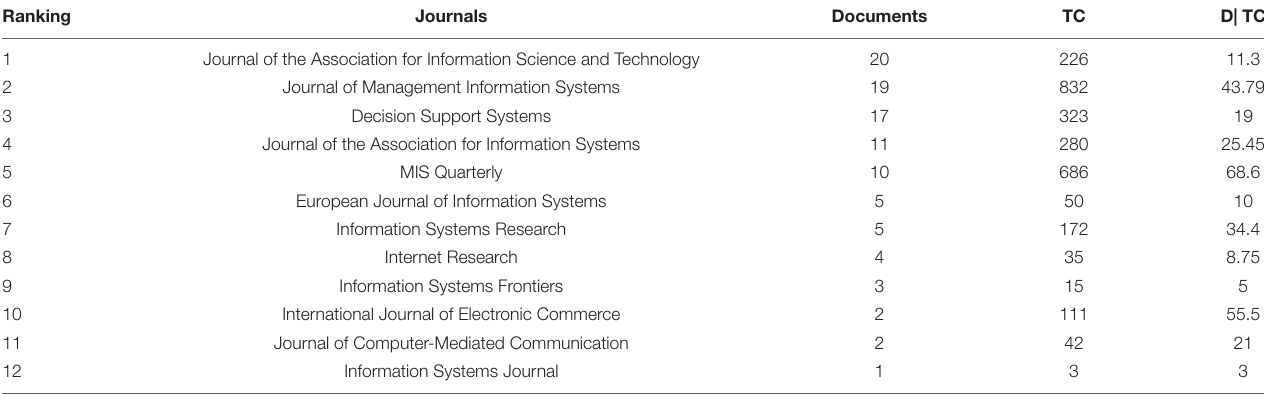
TABLE 1 | The top 10 productive journals from 2010 to 2021.